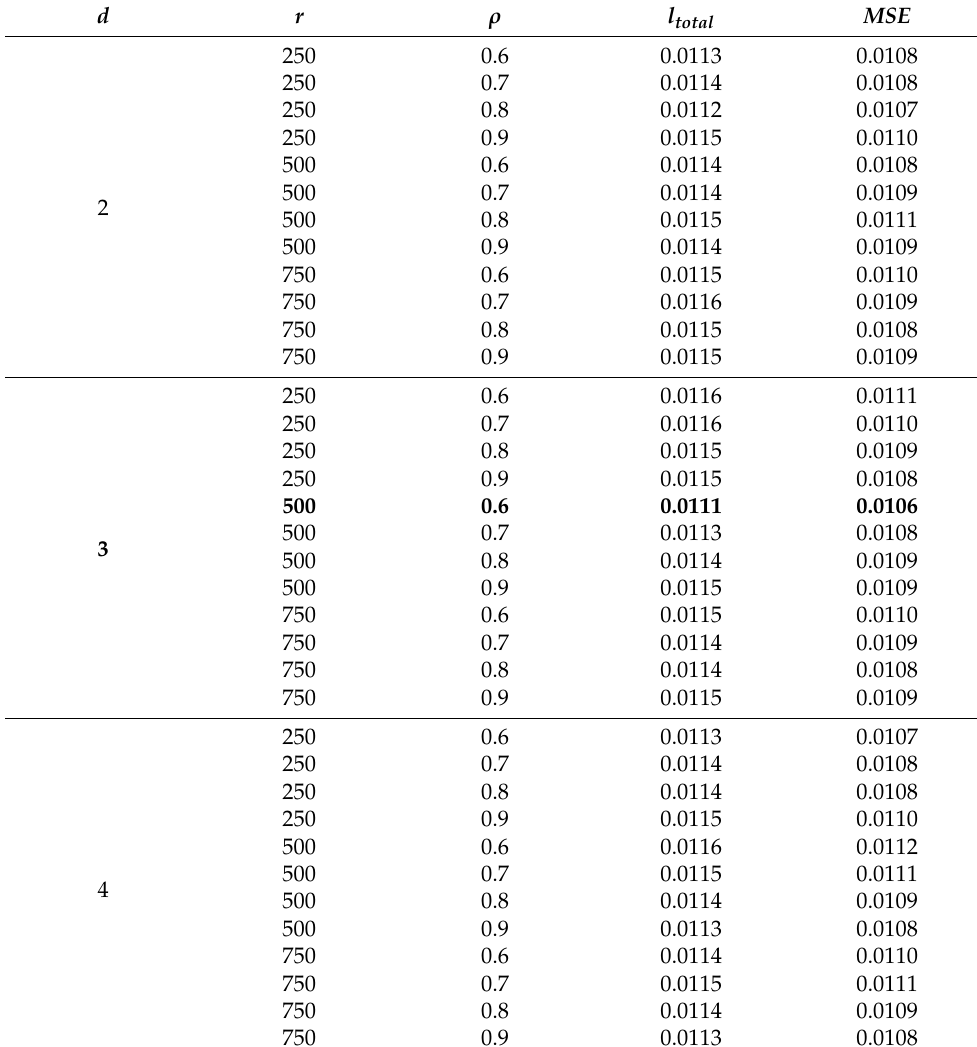
Table 2. Prediction results with different parameters in the Western Buffer District. The bold numbers are the best